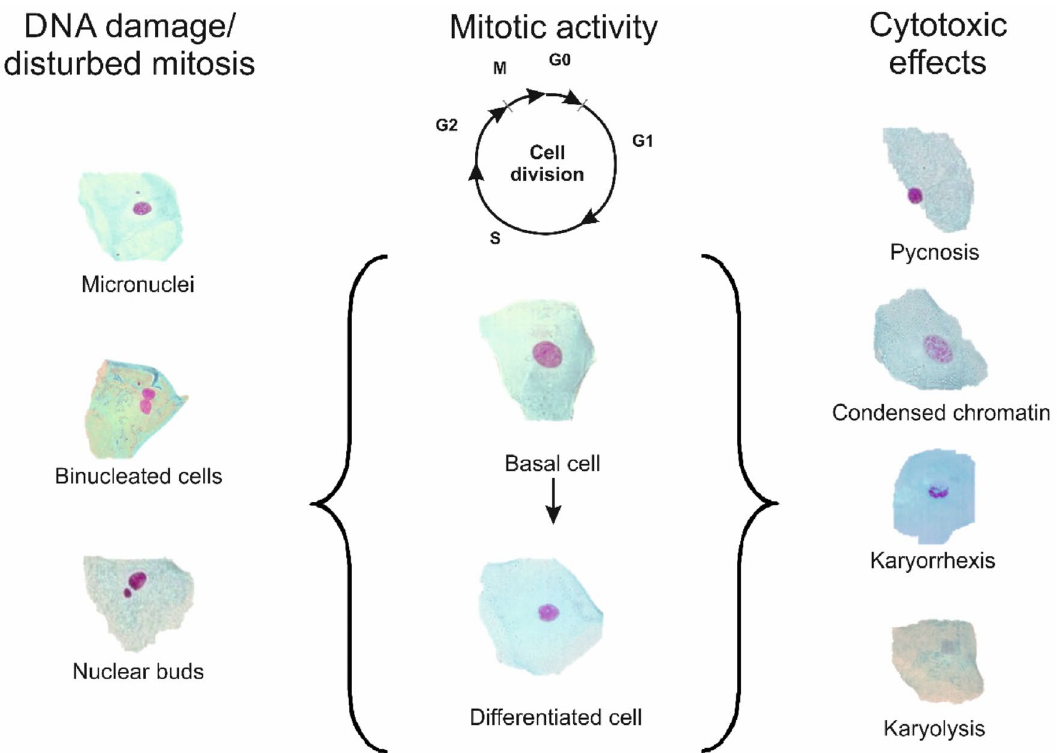
Figure 1. Morphology of different anomalies which are scored in MN-cytome experiments with buccal cells. For a detailed description of the characteristics of the different anomalies and scoring criteria see Refs. 23,50